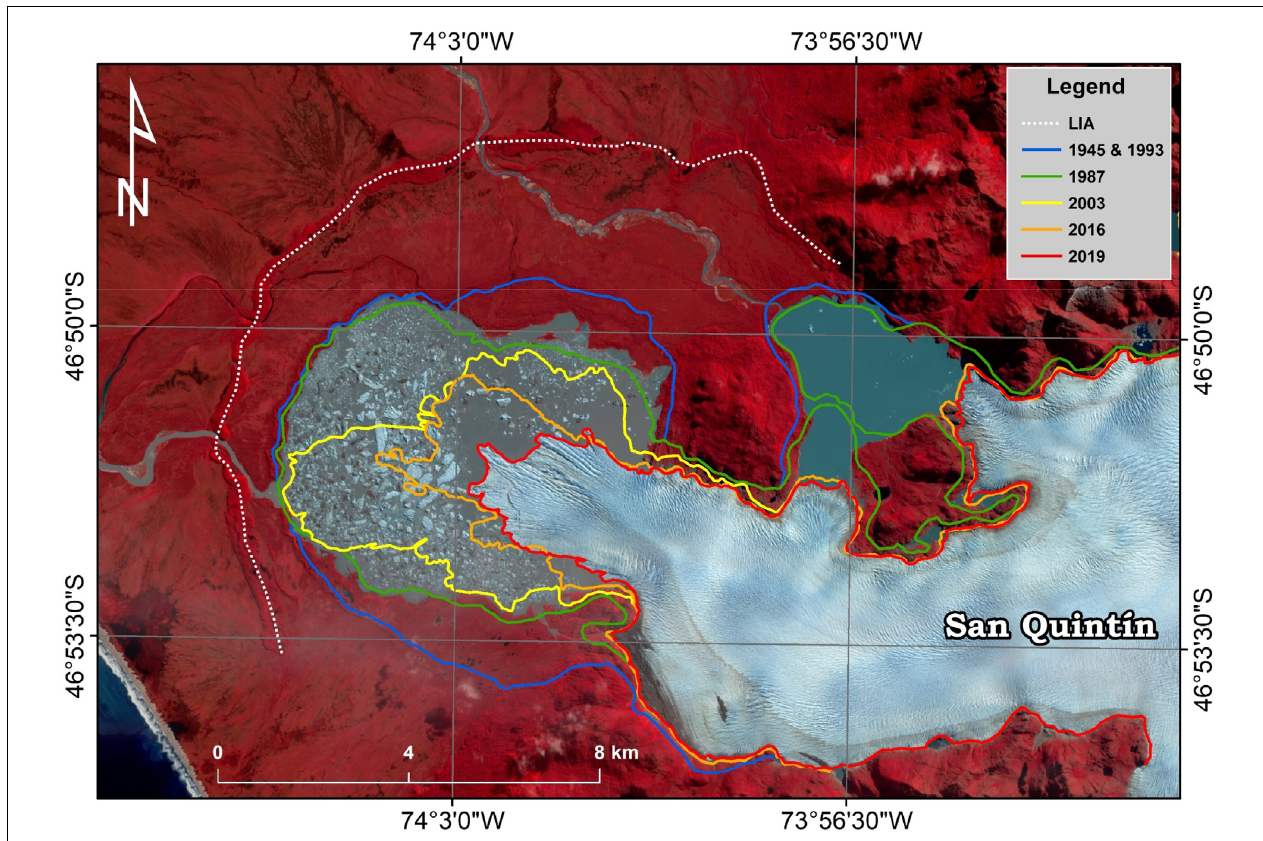
FIGURE 6 | Areal changes of San Quintín glacier between the LIA and 2019. San Quintín is the largest outlet glacier of the North Patagonian Icefield. Sources of data: Geomorphological reconstructions and available aerial photographs and satellite